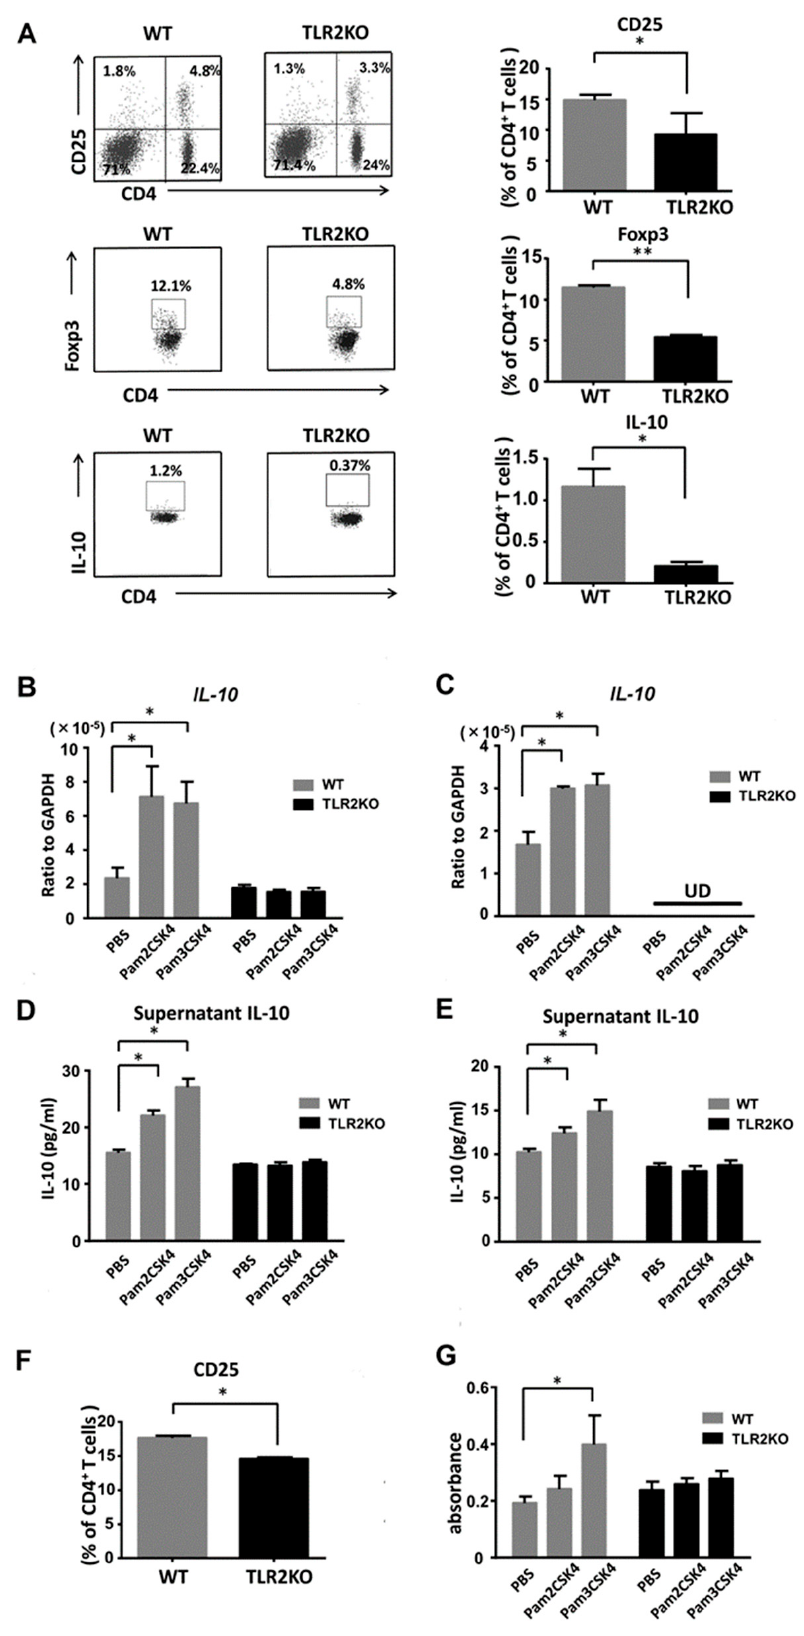
Figure 4. TLR2 regulates proliferation of Tregs and IL-10 production by DCs and Tregs. Wild-type (WT) and TLR2 knockout (TLR2 KO) mice were treated as described. At day 2, cell suspensions from the draining lymph nodes were stimulated with PMA and ionomycin and were stained with